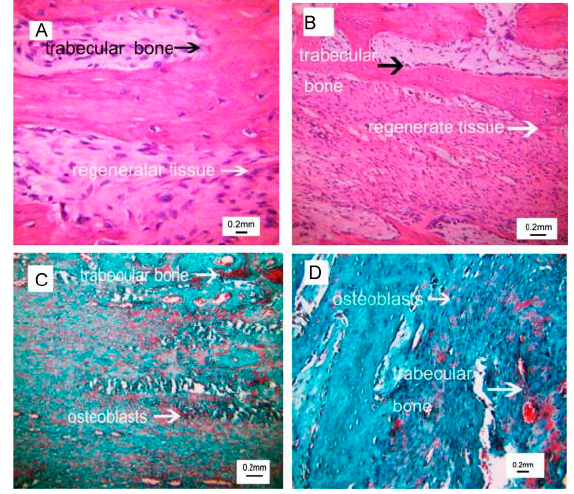
Figure 3. ( a ) HE staining on the experimental groups, ( b ) HE staining on the control group, ( c ) Masson staining on the experimental group, and ( d ) Masson staining on the control group. Reproduced with permission from [73], Elsevier, 2014.